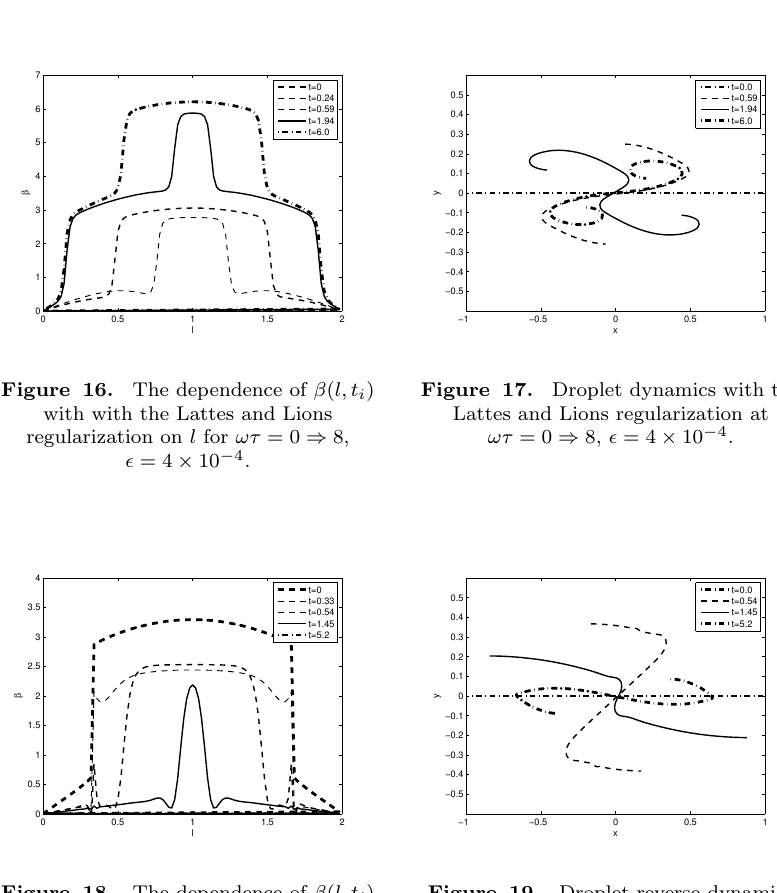
Figure 18. The dependence of β ( l,t i ) Figure 19. Droplet reverse dynamics on l for ωτ = 5 ⇒ 0, t f = 6 using reverse at ωτ = 5 ⇒ 0, t f = function.